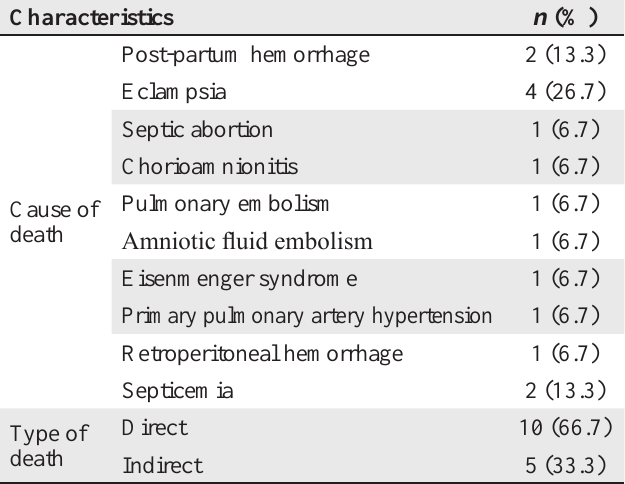
Table 4 : Cause and type of maternal death (N = 15)